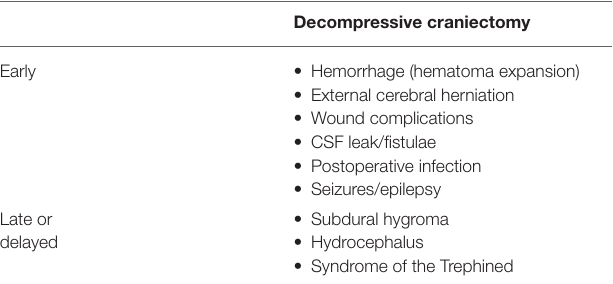
TABLE 1 | Overview of complications associated with decompressive